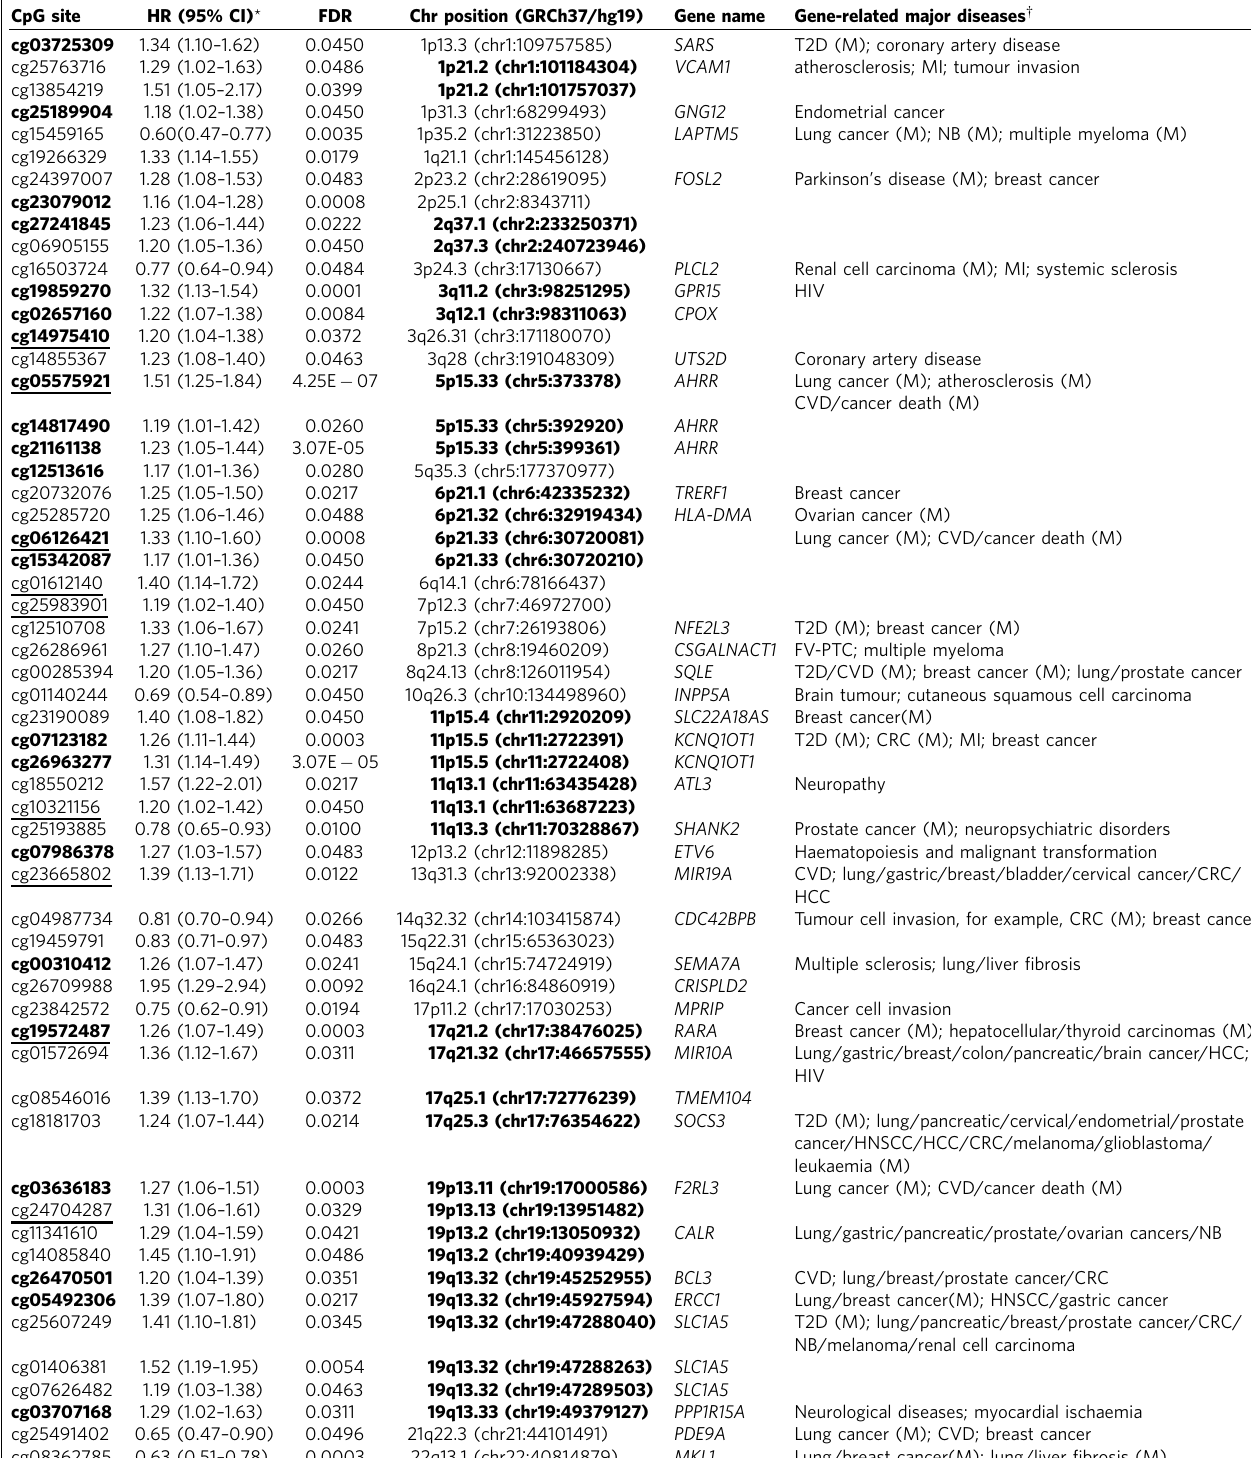
Table 2 | Association of 58 CpGs with all-cause mortality in the validation